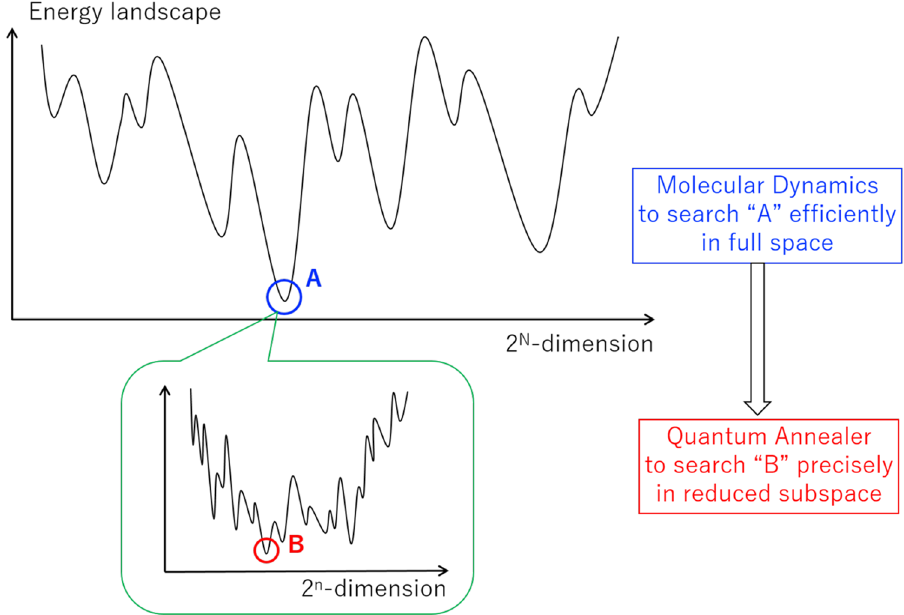
Figure 1. Concept of hybrid quantum annealing via molecular